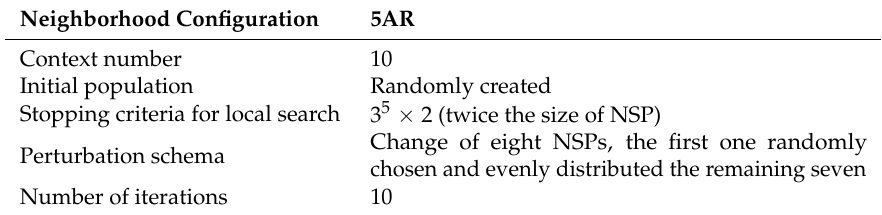
Table 4. Proposed parameters to get the best